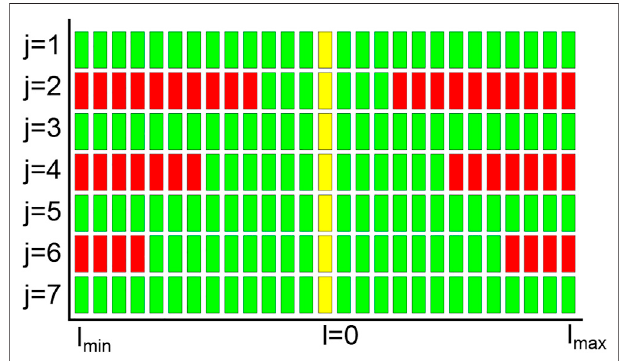
FIGURE 9 | Normalized failure diagram for a given pose ξ ; the ranges of the seven joints j have been normalized for illustration purposes (naturally, each joint has its own joint limits, which do not necessarily coincide). Yellow cells represent the current joint con fi guration, in this case, the upright position (all joints at zero). Green/red cells represent reachability maps W j , l ( ξ ) that do/do not contain the pose ξ